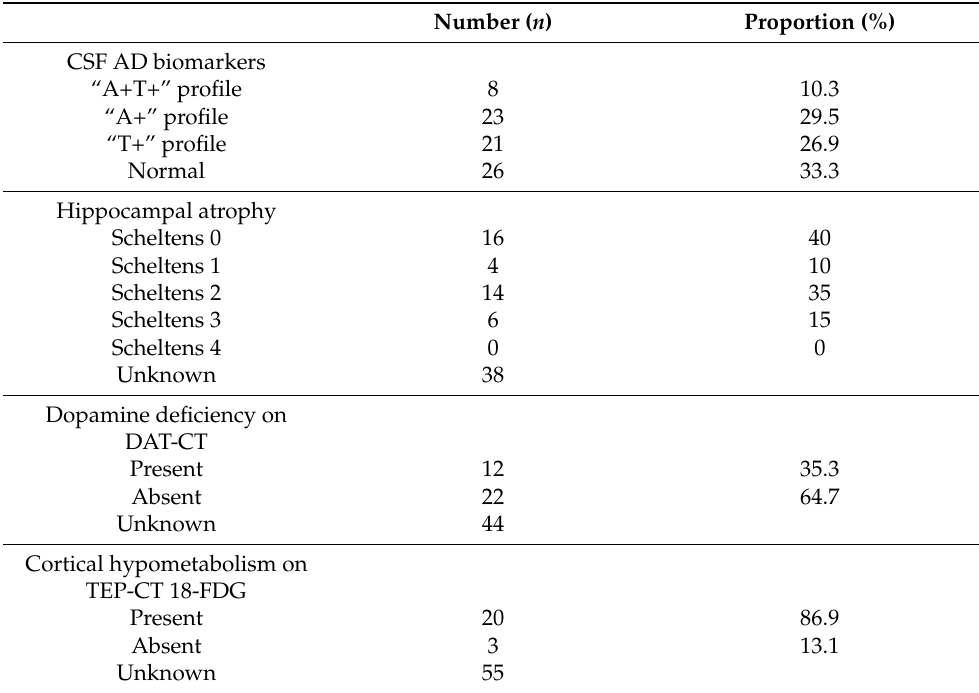
Table 4. Imaging and